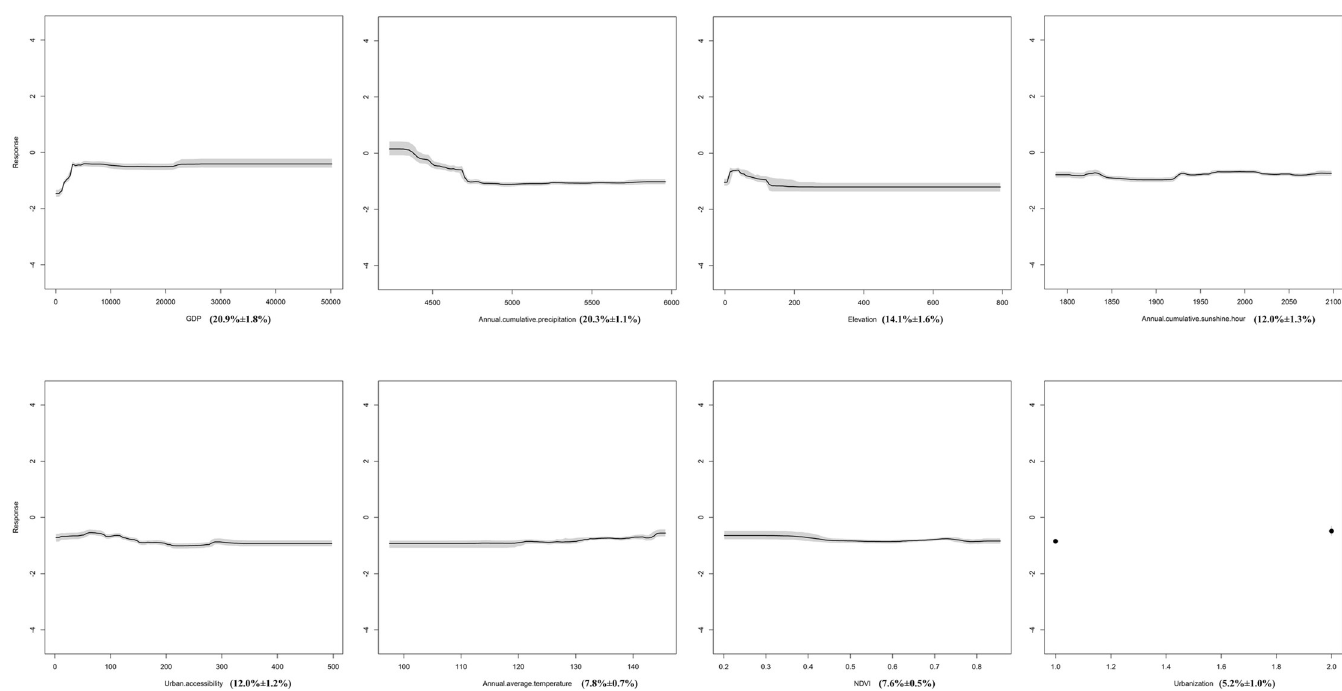
Fig 4. Marginal Effect Curves of Each